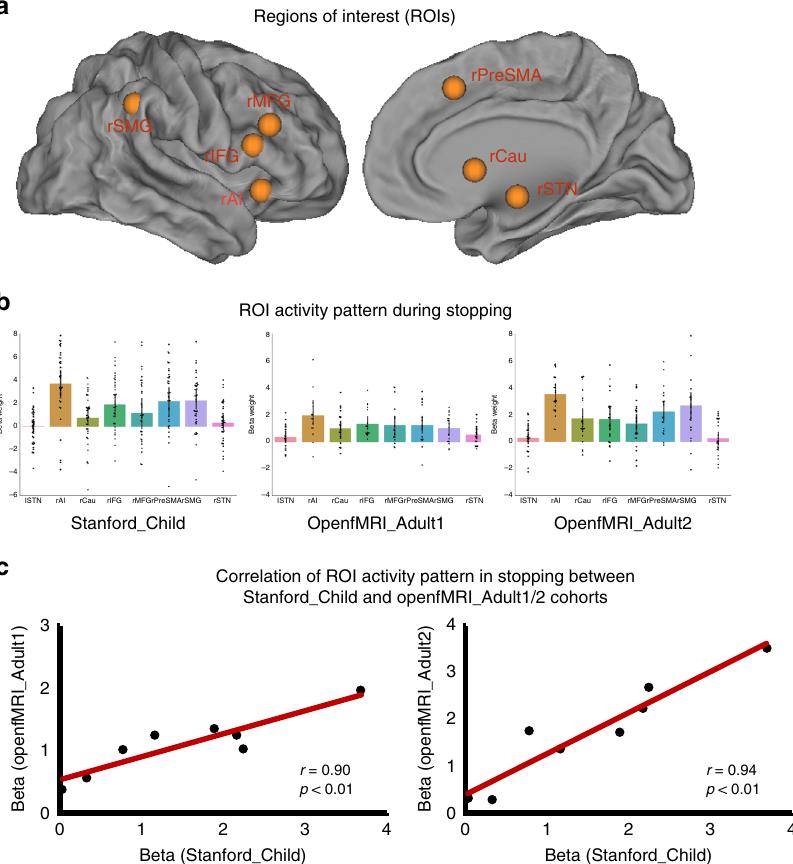
Fig. 5 Similarity of regional activation in children and adults. a Regions of interest (ROIs), as determined by a previous meta-analysis of the stop signal task (SST) in adults 17 . ROIs consisted of right anterior insula (rAI), right inferior frontal gyrus (rIFG), right middle frontal gyrus (rMFG), right pre-supplementary motor area (rPreSMA), right supramarginal gyrus (rSMG), and right caudate (rCau). Left and right subthalamic nuclei (lSTN and rSTN) ROIs were based on a high-resolution 7T structural MRI study 28 . b ROI analyses revealed greater activation in stopping (SuccStop versus Go) in rAI, rCau, rIFG, rMFG, rPreSMA and rSMG in children and two adult cohorts (Bonferroni-corrected for multiple comparisons). Error bars represent standard deviations. c ROI activation pattern elicited by stopping in children was signi fi cantly correlated with activation patterns in two different cohorts of adult. Source data are provided as a Source Data fi